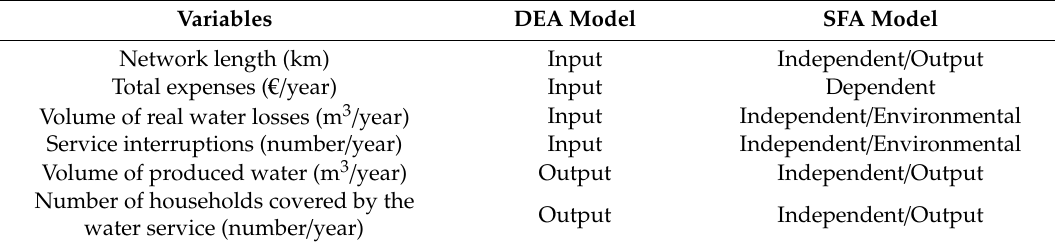
Table 1. Configuration of the variables for the data envelopment analysis (DEA) and stochastic frontier analysis (SFA)